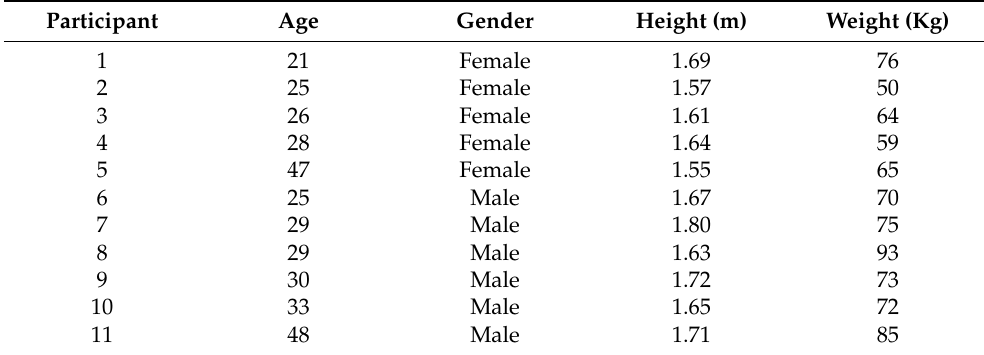
Table 1. Physical characteristics of the recruited participants.